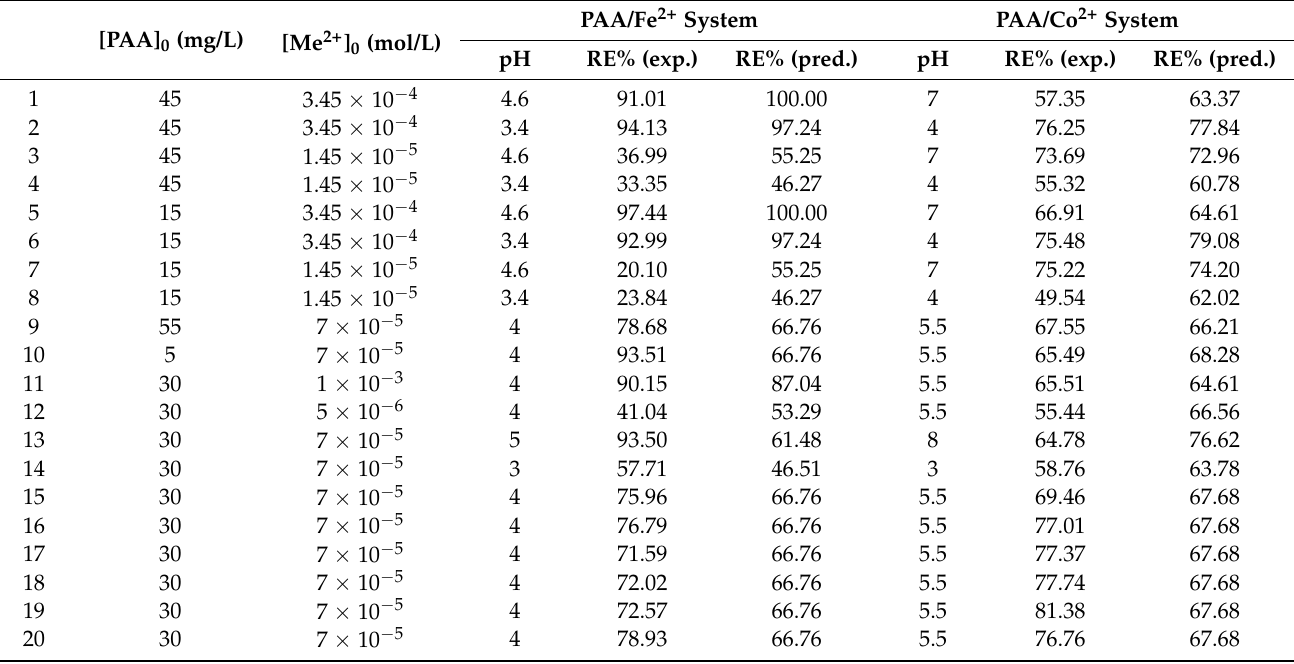
Table 3. The three-factor CCD matrix, with the experimental and predicted removal efficiency values for UV-326 degradation.